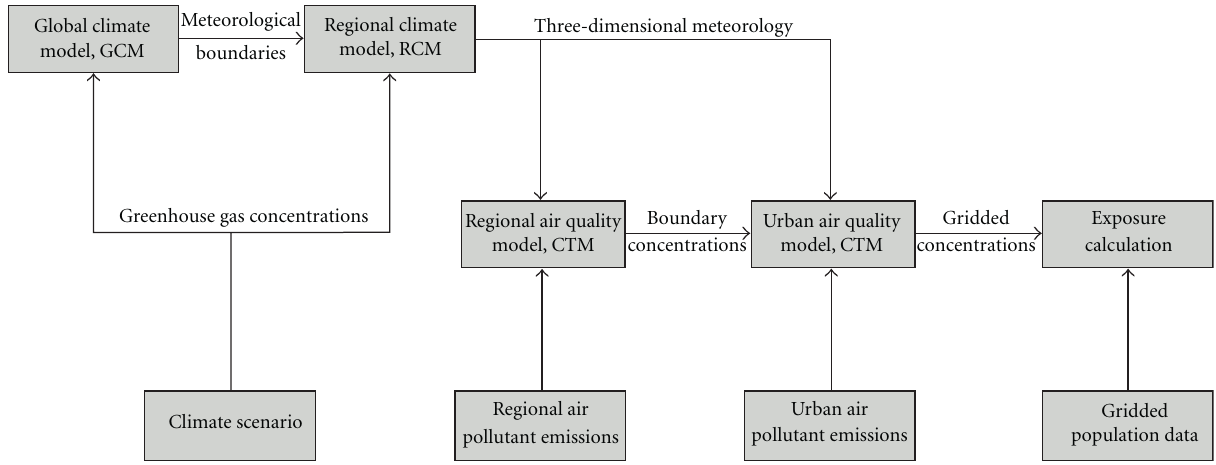
Figure 1: Conceptual overview of the model chain used in the present study. The global climate models ( ECHAM5 A1B-r3 and HadCM3 A1B-ref ) utilizing the A1B climate scenario are being regionally downscaled by the Rossby centre regional climate model, RCA3. The regional and urban air quality models (MATCH) are driven by the same three-dimensional meteorology but forced by di ff erent emissions estimates, the urban air quality model takes boundary concentrations from the European-scale air quality model. The calculated near-surface concentrations from the urban scale air quality simulation are finally coupled to gridded population data to produce population exposure in the urban